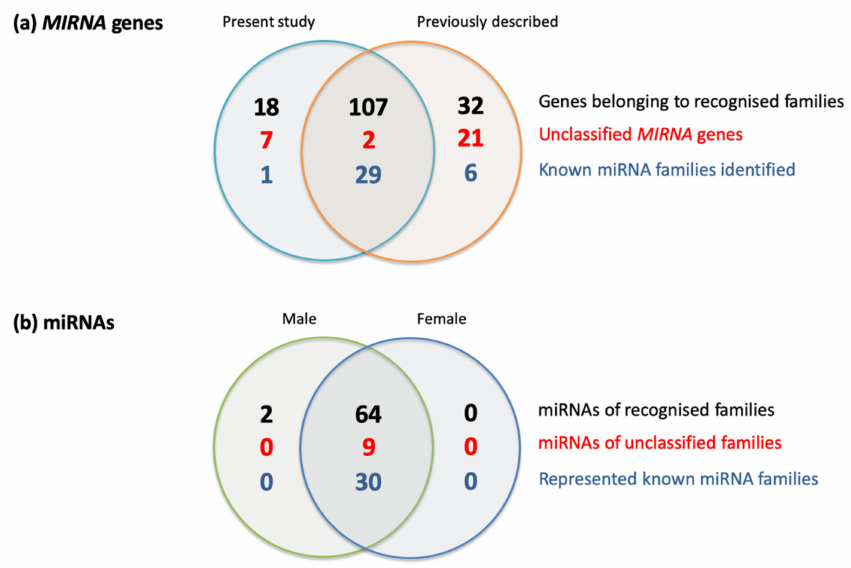
Figure 2. Venn diagrams summarizing oil palm miRNA data from the present study along with pre-existing (sRNAanno database)